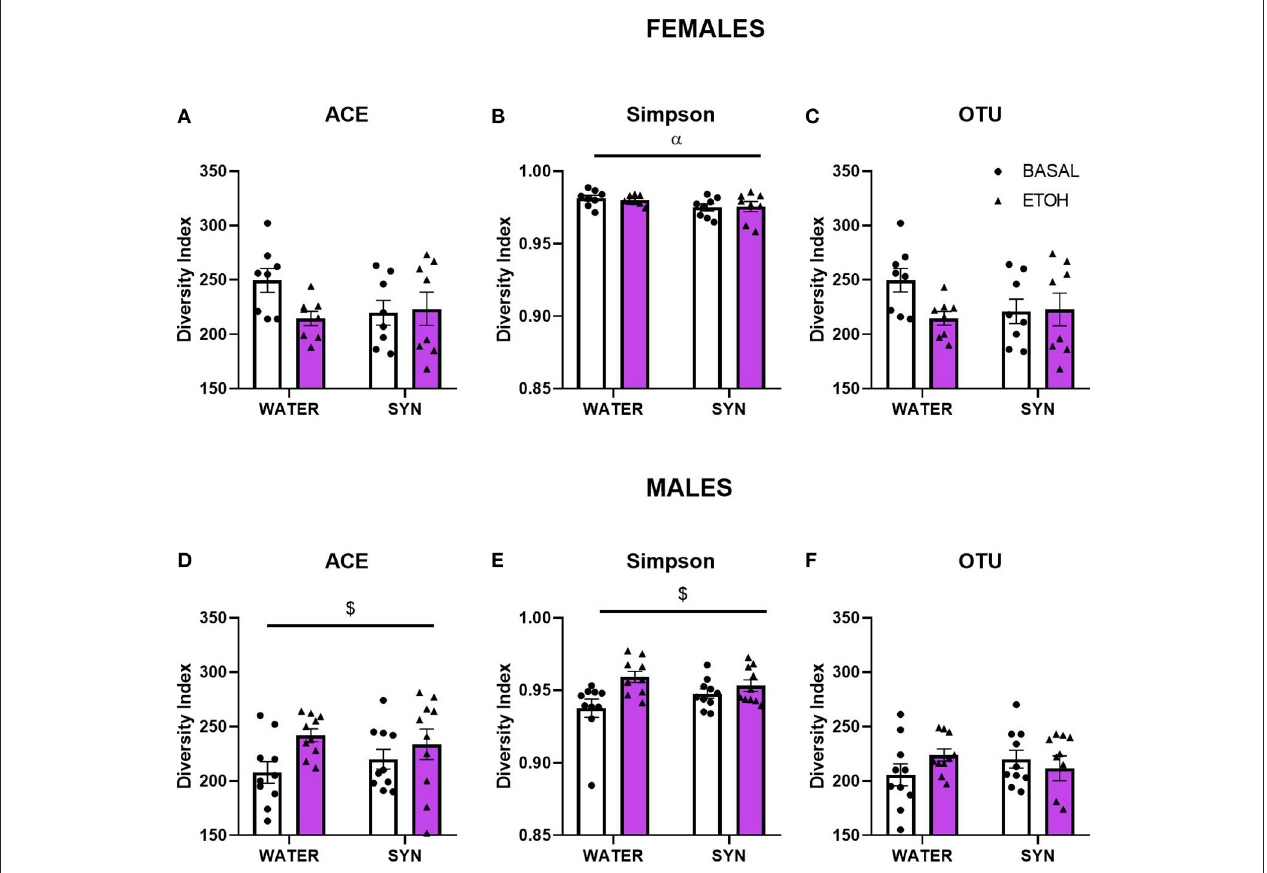
FIGURE 5 | Changes in gut microbiota alpha diversity in female and male mice treated with water or synbiotic (SYN) following 2 weeks of baseline (BASAL; no alcohol; white bars, round symbols), and after 20 days of intermittent access to alcohol (ETOH, violet bars, triangular symbols). (A,D) The ACE richness index, (B,E) the Simpson diversity index, and (C,F) the OTU abundance. α p < 0.05 (main effect of treatment); $ p < 0.05 (main effect of alcohol) following 2-way ANOVA.